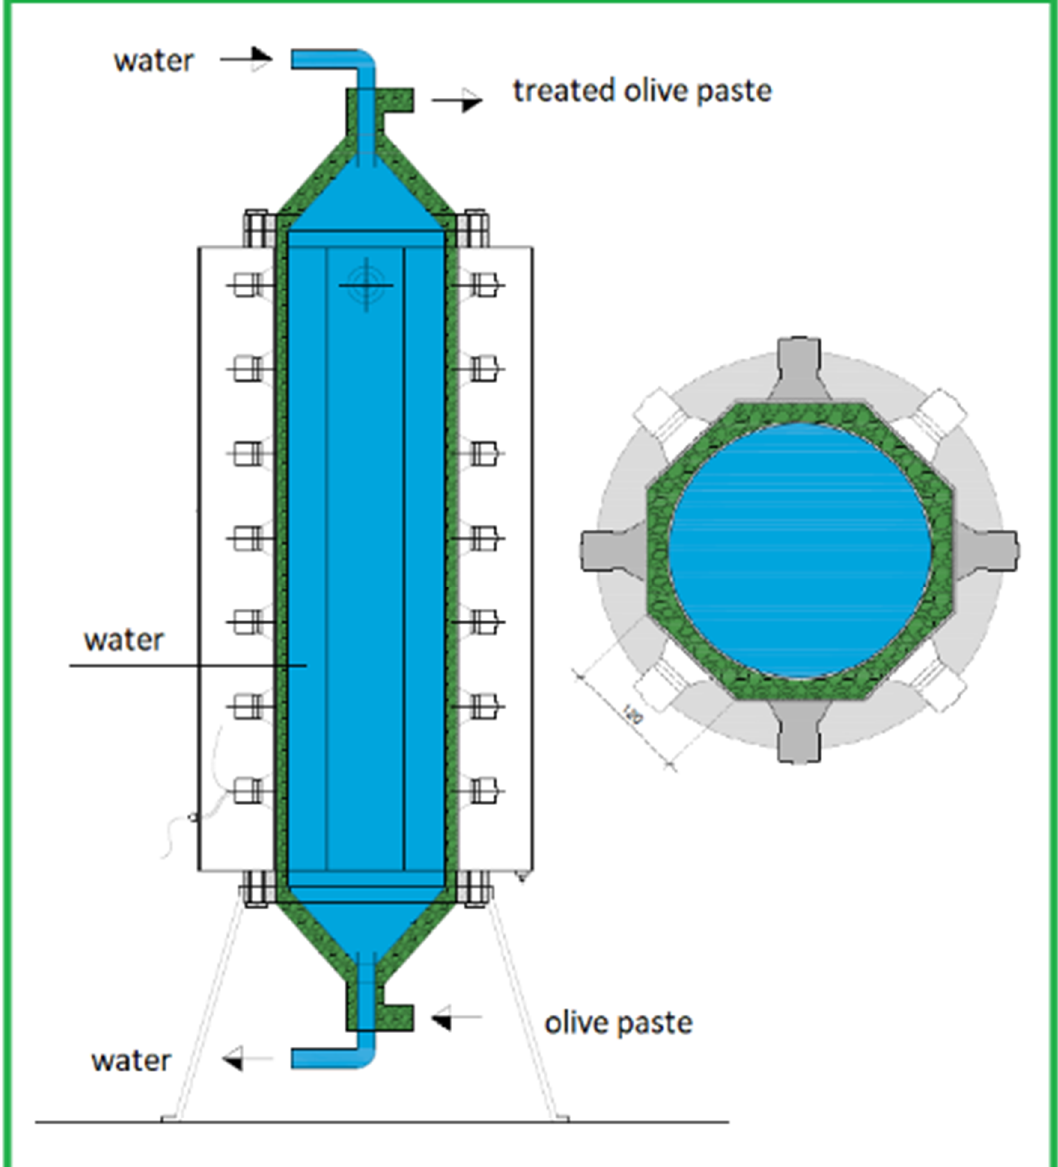
Figure 5. The innovative sono-heat exchanger equipped with button-shaped transducers.